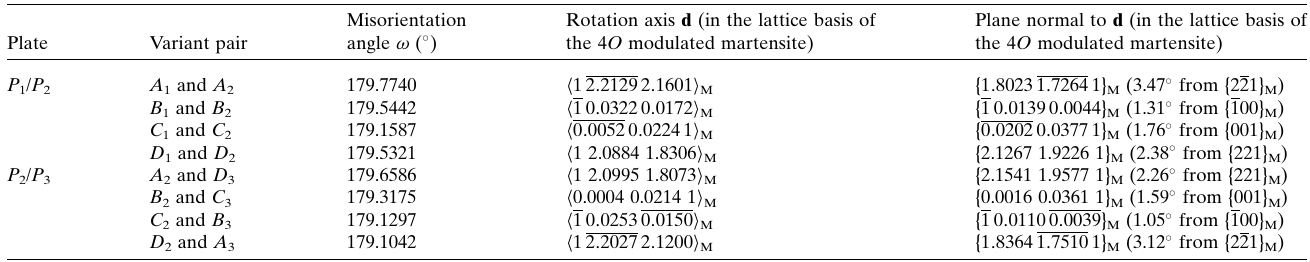
Table 1 180 (cid:2) rotation ( ! , d ) and the plane normal to the rotation axis d of the interplate variant pairs in plates P 1 and P 2 , and P 2 and P 3 . Plate Variant pair